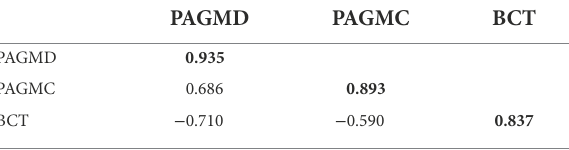
TABLE 4 Correlation matrix of the reflective constructs.